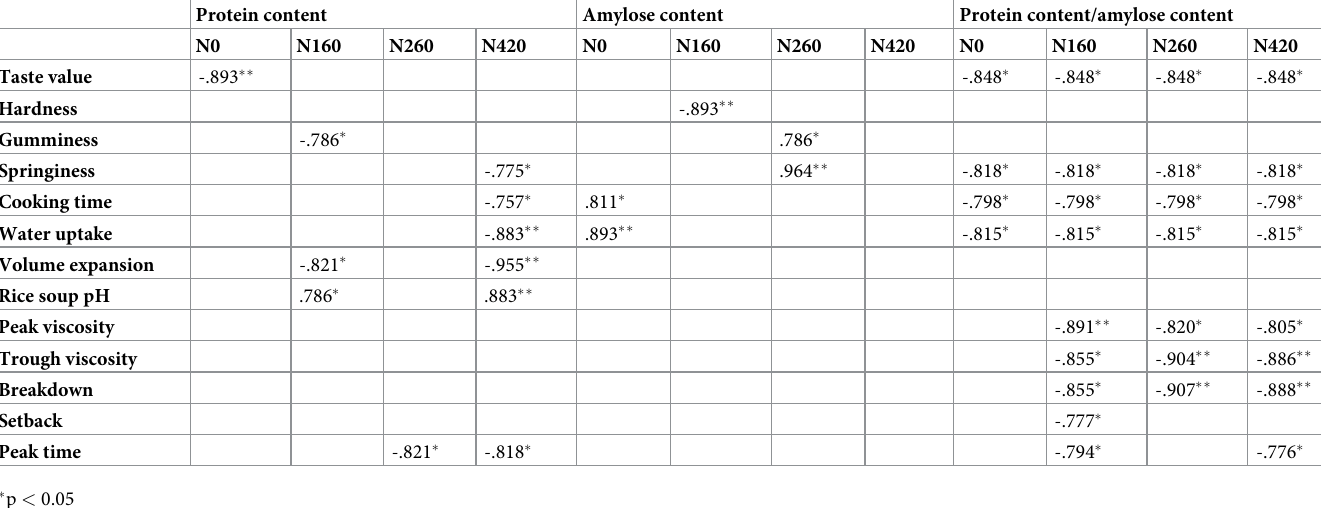
Table 1. Correlation analysis between taste quality indices and chemical composition changes of rice during storage, following different nitrogen application rates. Protein